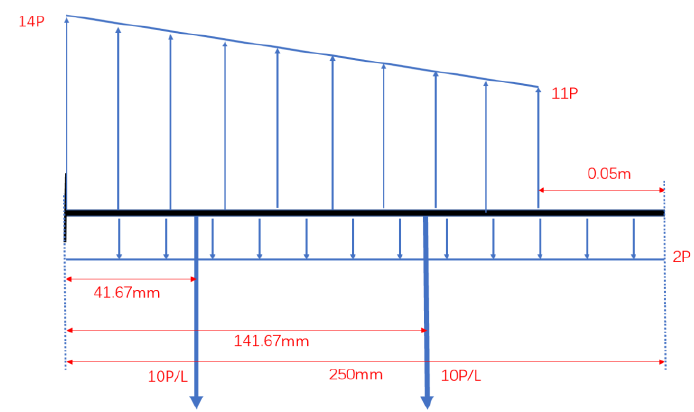
Figure 16. External loading representative of air-foil.